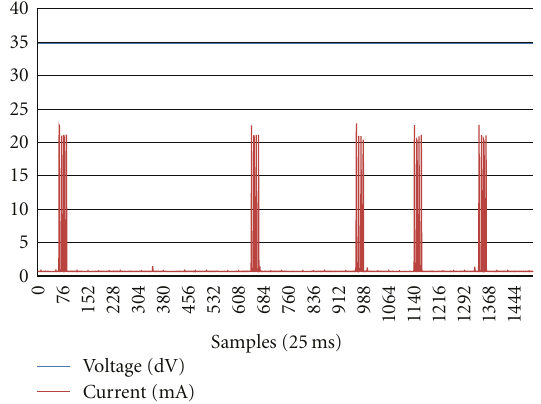
Figure 8: Battery emulation on node 8: 3.49 V and 2000 mAh capacity. The application sends one packet every 7 second (ran- dom). The available energy decreases very slowly.